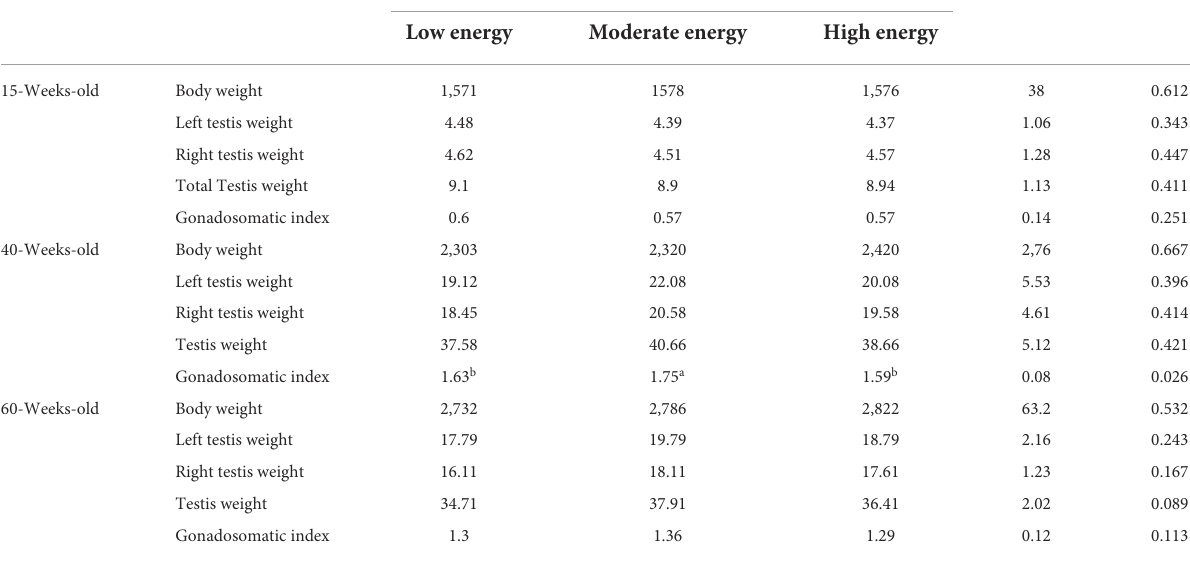
TABLE 3 Effects of different energy levels on gonad development in different